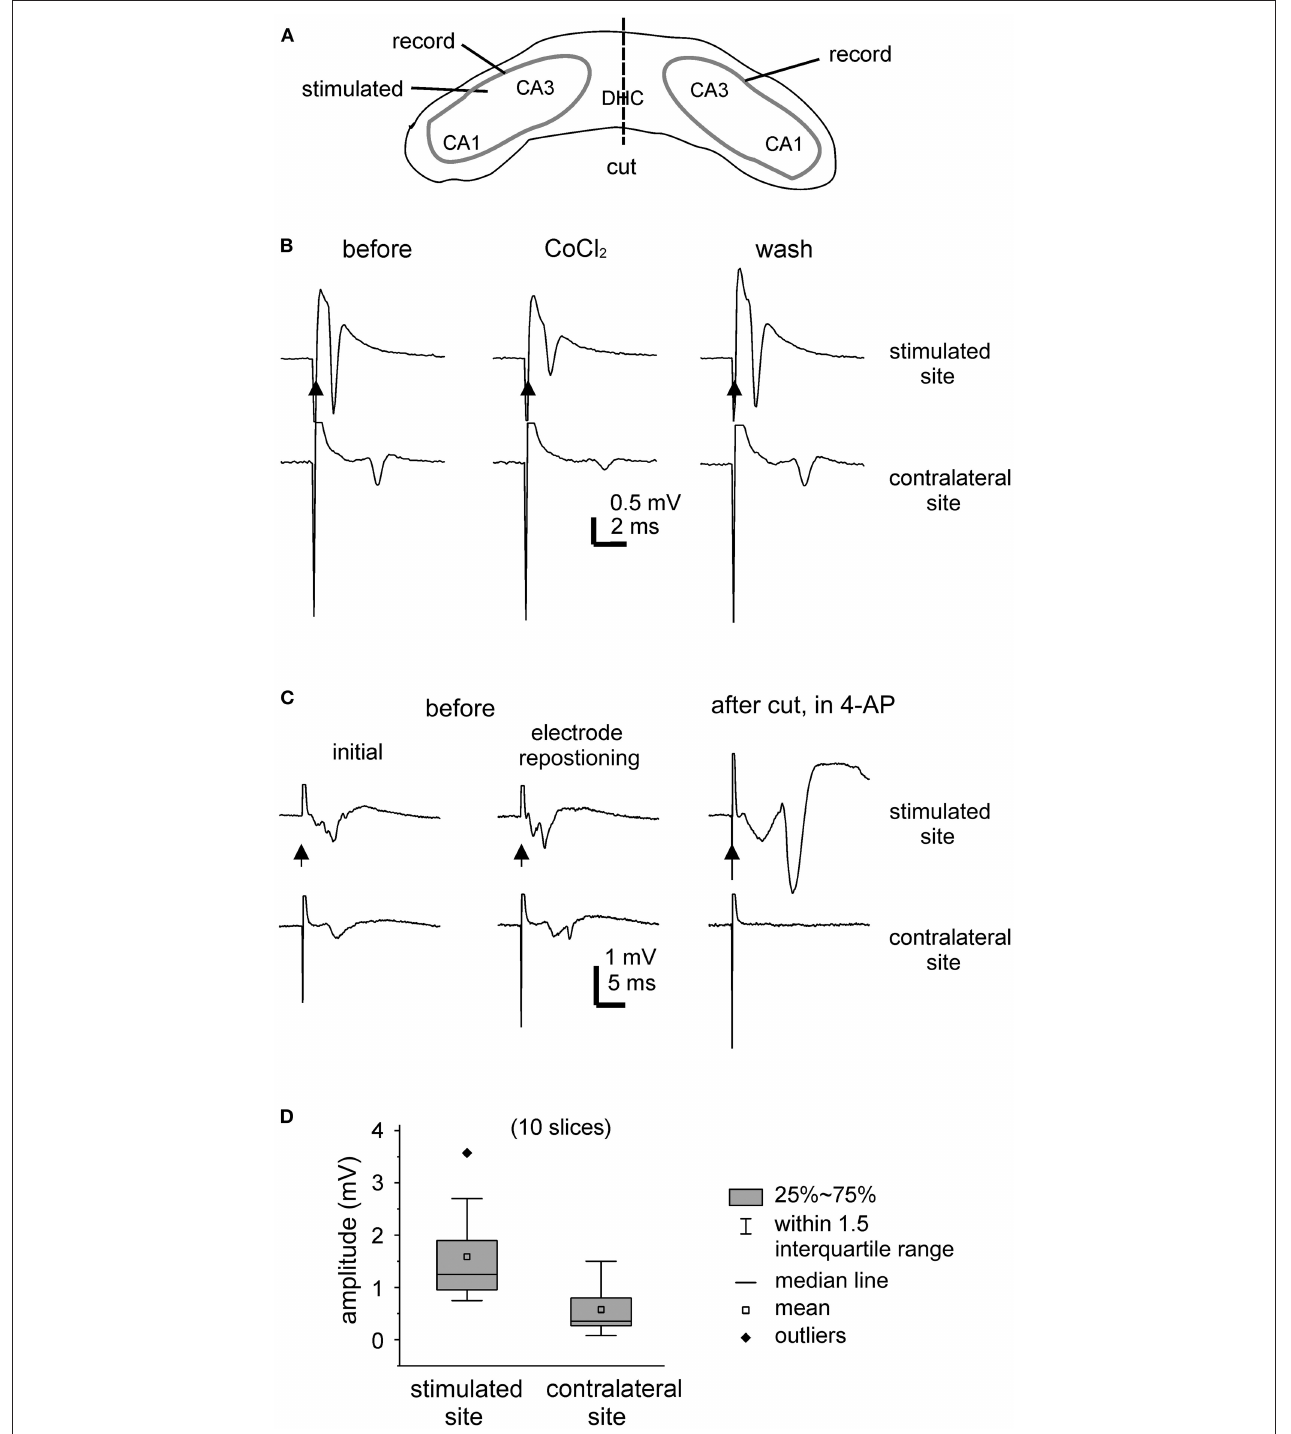
FIGURE 2 | Unilaterally elicited and bilaterally recorded synaptic field potentials. (A) A carton showing the positions of stimulating and recording electrodes. (B,C) Bilateral hippocampal slices were obtained from 2 mice (21- or 23-days-old). CA3 population spikes were evoked unilaterally and recorded bilaterally. Illustrated traces were averaged from five consecutive responses. Filled arrows denote the unilateral afferent stimulation. (B) The evoked responses collected before (left), after the application of 2mM CoCl 2 for about 8min (middle), and after washing out the cobalt (right). (C) The evoked responses collected initially (left), after repositioning two recording electrodes (middle), and following the application of 100 µ M 4-AP and after a cut that was made at the DHC (right). (D) Box plots showing the peak amplitudes of evoked CA3 population spikes. Measurements were made from the stimulated and contralateral sites in 10 slices.